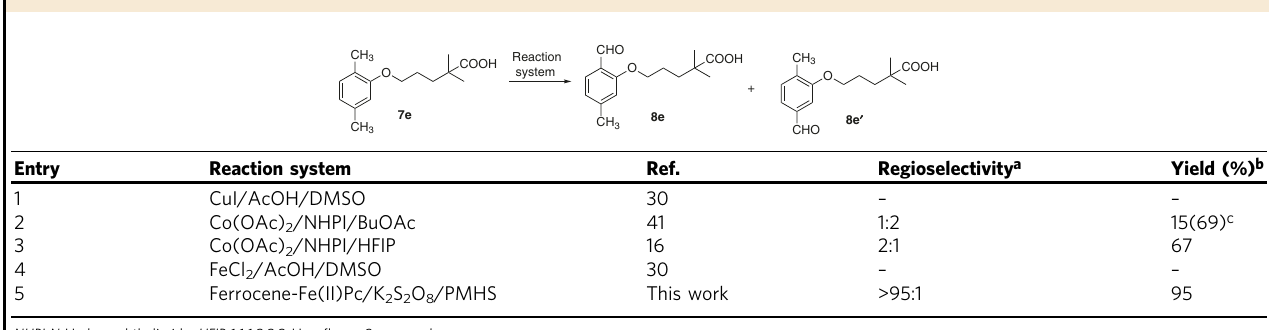
Table 2 Comparison of catalyst systems